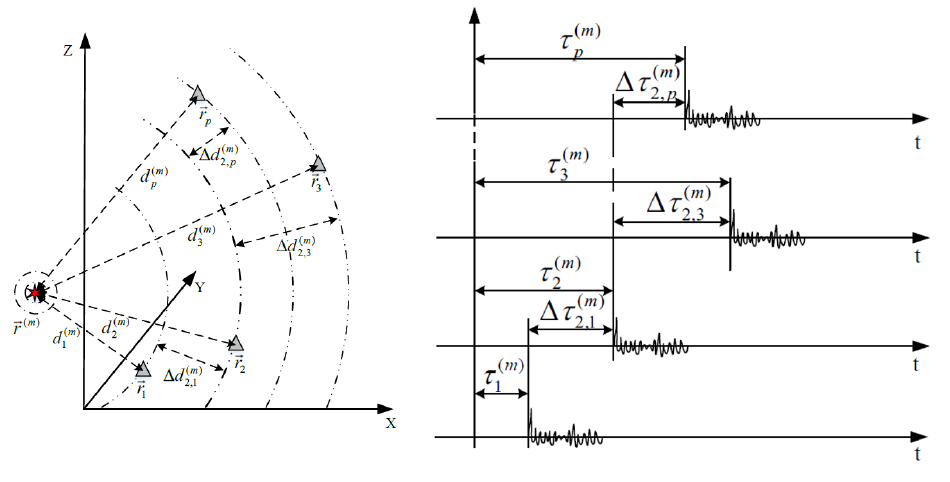
Figure 1. The scenario in the region of interest ( left ), with time delays and relative time delays ( right